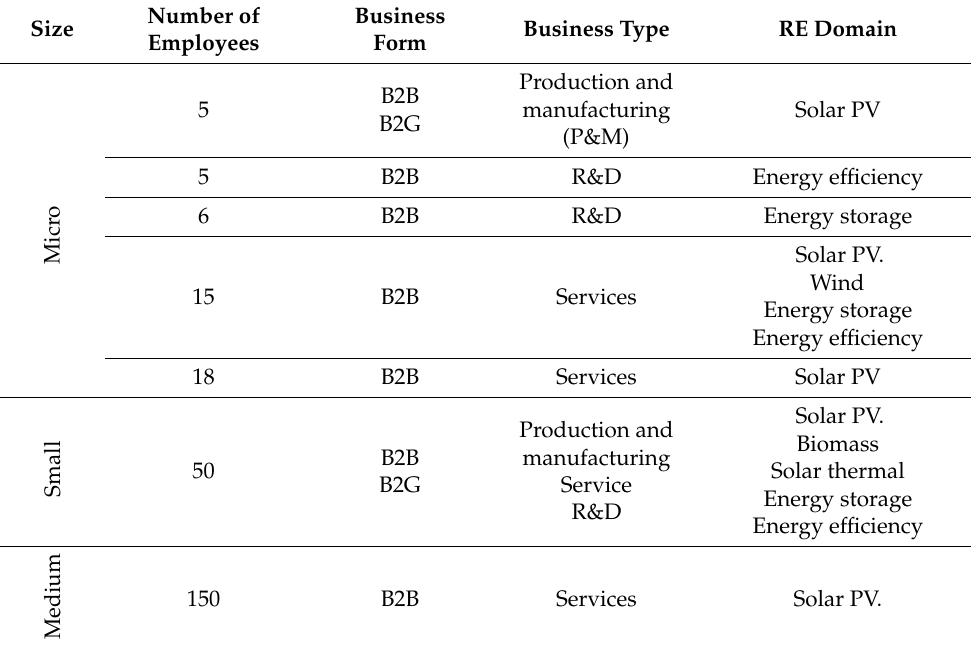
Table 1. Characteristics of the start-up enterprises involved in this